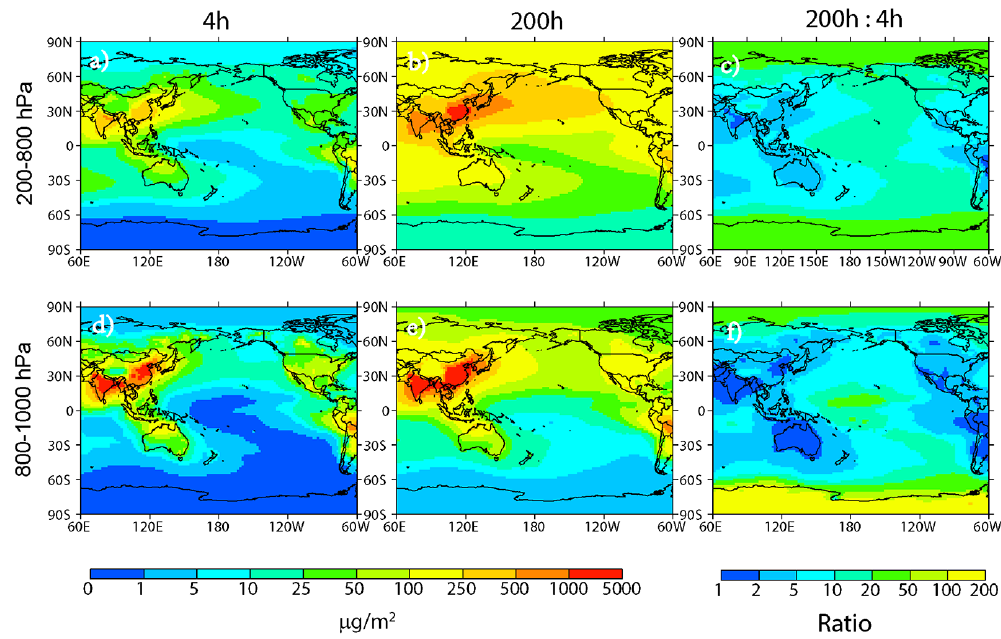
Figure 2. The annual averaged (2009–2011) column burden of BC at 200–800hPa (a, b) and 800–1000hPa (d, e) when aging timescale is 4h (a, d) and 200h (b, e) . The ratio of BC burden for simulations with aging timescale of 200h and 4h is shown in (c) and (f)